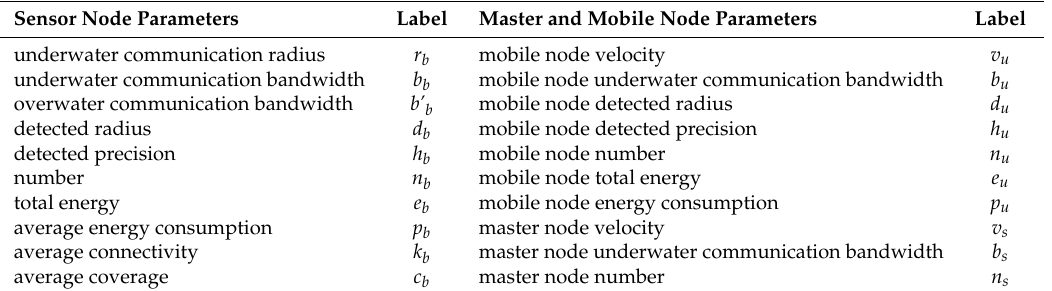
Table 1. Parameters and